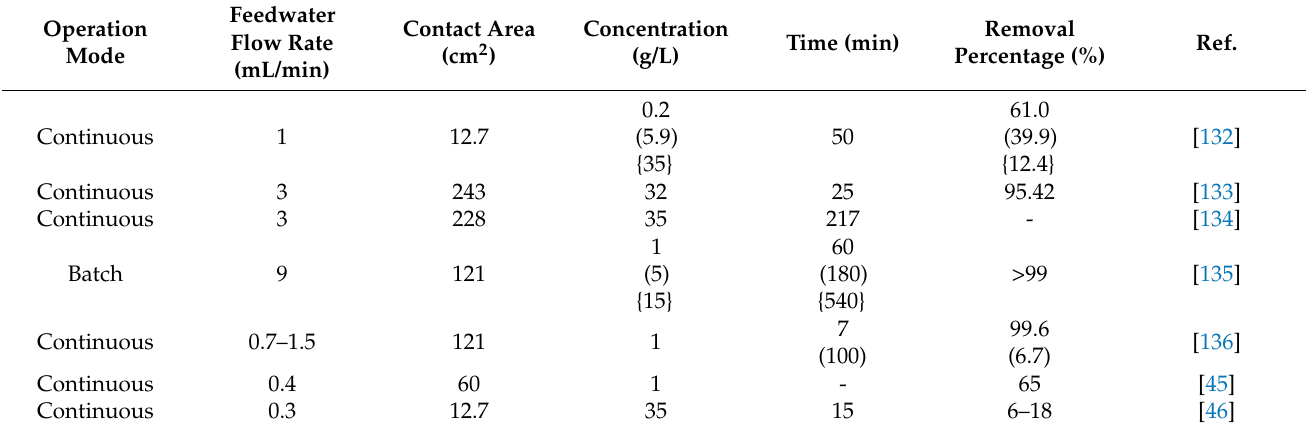
Table 3. Comparison of CDI performance of AC at 1.2 V but different cell configurations and operation